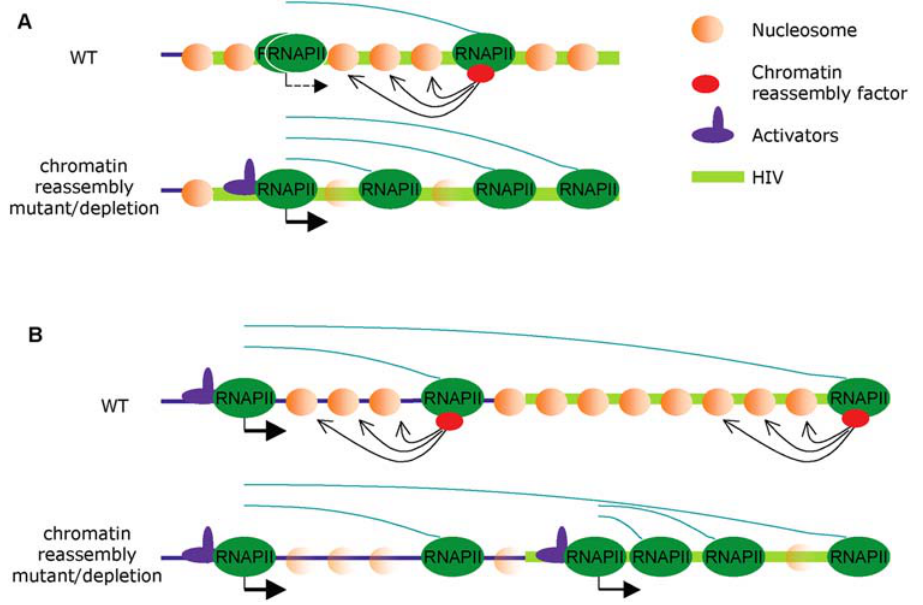
Figure 5. A model for the contribution of chromatin reassembly factors to the repression of HIV basal transcription. (A) Chromatin reassembly factors, recruited by the elongating form of RNApol II, stabilize nucleosomes on the transcribed region, keeping basal transcription at low rates. In the absence of chromatin reassembly factors, nucleosomal configuration of the transcribe region becomes instable, increasing basal transcription and eventually favoring promoter activation. (B) Chromatin reassembly factors may also contribute to the silencing of HIV by transcriptional interference. HIV proviruses integrated in highly expressed genes would remain untranscribed due to the repressive chromatin configuration established by chromatin reassembly factors during transcription elongation. In the absence of chromatin reassembly factors, nucleosomes repressing the 5 9 -LTR become instable, allowing transcription factors to activate the HIV promoter.